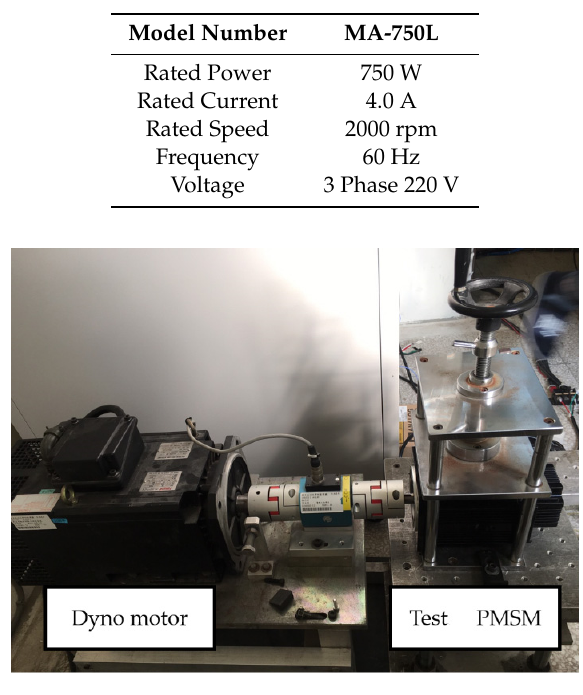
Figure 2. Test bench to actualize demagnetization fault in a PMSM.